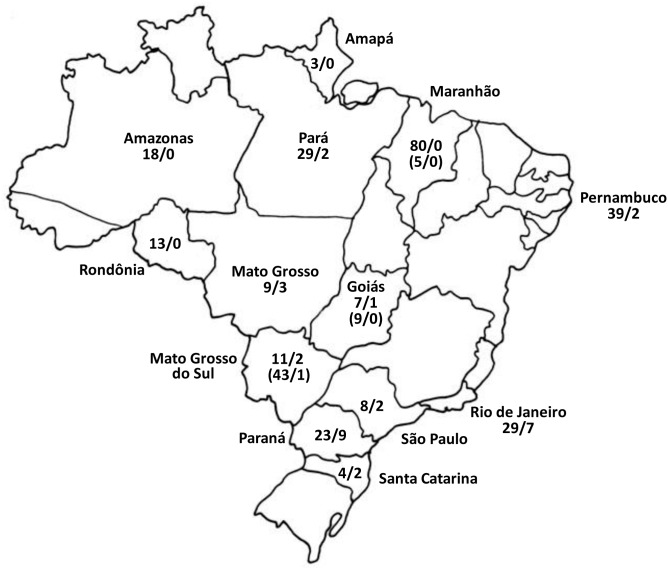
Geographical distribution of HBV/A1 and A2 isolates in Brazil, including the 26 isolates characterized in this work.Numbers indicate the ratios A1/A2. Numbers in parentheses refer to semi-isolated Afro-Brazilian communities which were established by the slave escapees during the 17th and 18th centuries. Data compiled from [24]–[27], [30], [43], [44].